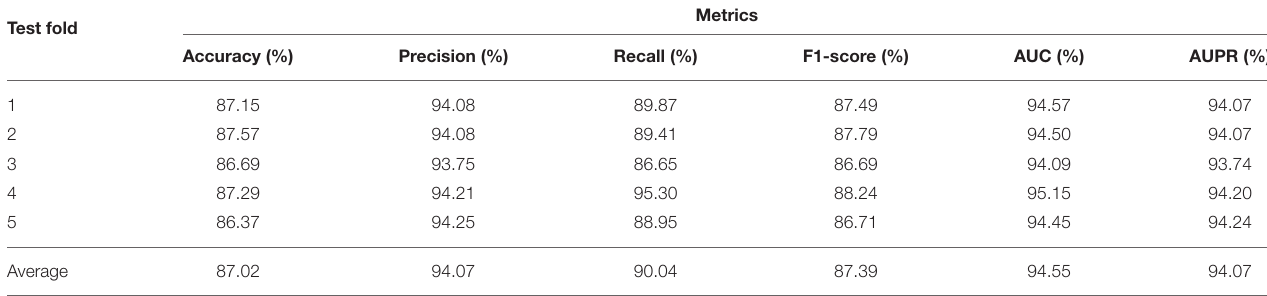
TABLE 1 | Results of five-fold CV based on HMDD v2.0. Test